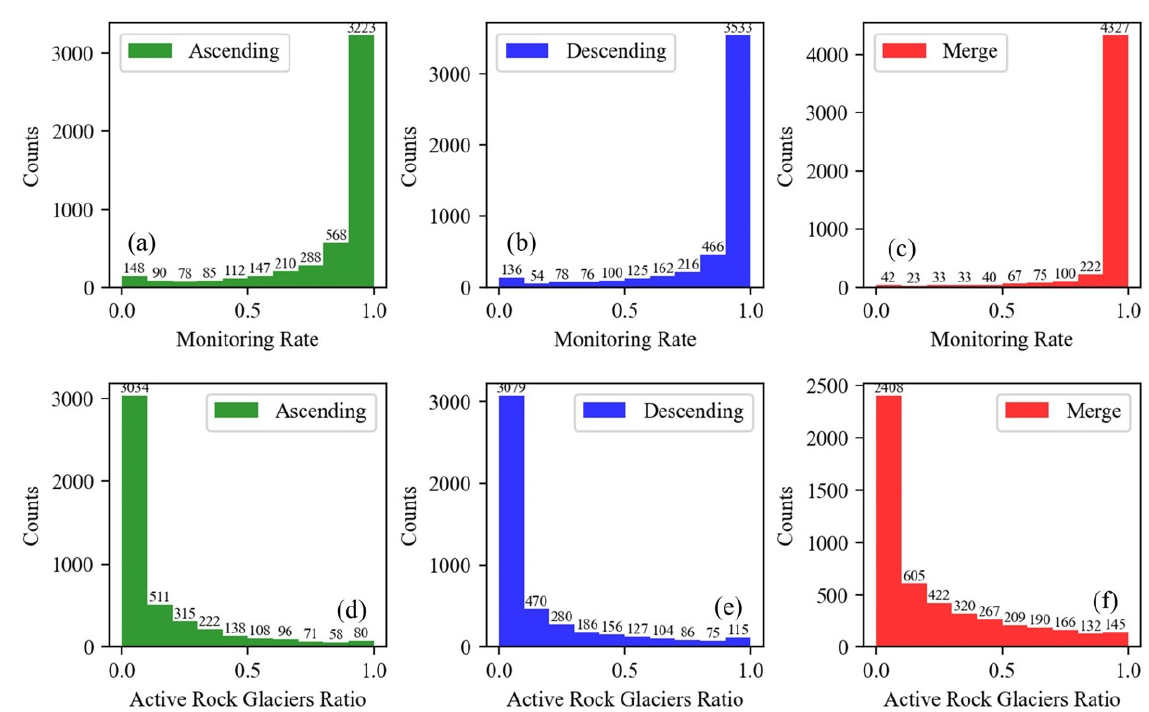
Figure 13. Rock glacier monitoring rates and active rock glacier ratio statistics. ( a ) Monitoring rate in ascending geometry. ( b ) Monitoring rate in descending geometry. ( c ) Monitoring rate after merging ascending and descending geometries. ( d ) Active rock glacier ratios in ascending geometry. ( e ) Active rock glacier ratios in descending geometry. ( f ) Active rock glacier ratios after merging ascending and descending geometries. Table 2. Active rock glacier statistics in the central